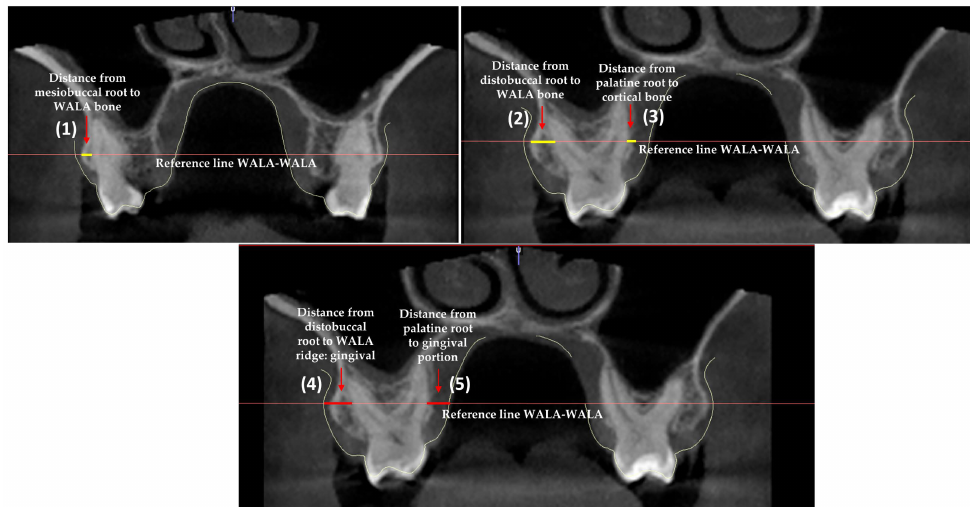
Figure 4. Representation of the 5 measurements made corresponding to each upper first molar. The measurements of the second upper molars were made in the same way but only for the bone variables. (1) Distance from mesiobuccal root to WALA bone: osseous V (MV). (2) Distance from distobuccal root to WALA bone: osseous V (DV). (3) Distance from palatine root to cortical bone: osseous P. (4) Distance from distobuccal root to WALA ridge: gingival (DV). (5) Distance from palatine root to gingival portion: gingival